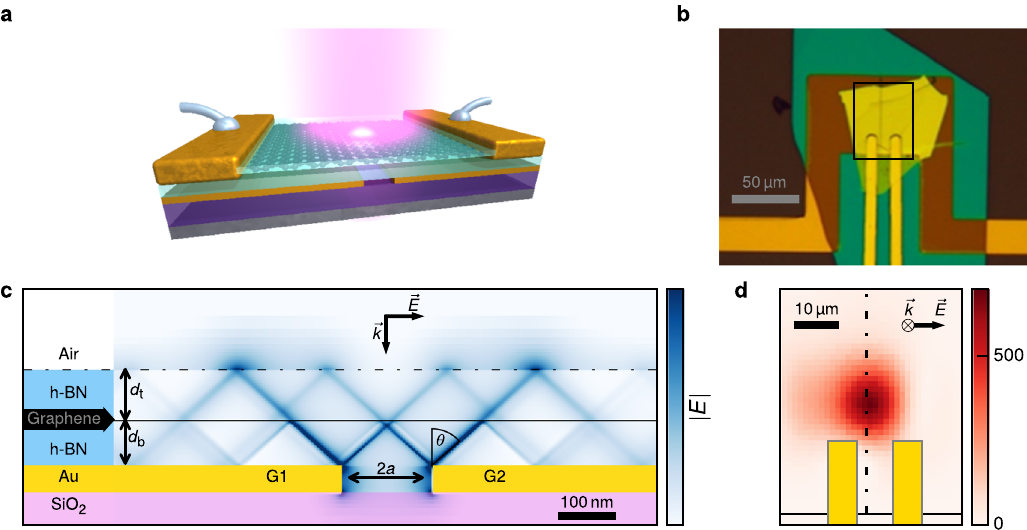
Fig. 1 Device schematic and working principle. a Schematic of the encapsulated graphene pn-junction. The h-BN/graphene/h-BN is placed on two gold split gates and contacted electrically by the edges. b Optical image of one device: the top ( bottom ) BN is blue ( yellow ). The black rectangle indicates the measurement region in d . The distance between the two gates in this device is 100 nm. c Side view of the propagating hyperbolic phonon-polaritons simulated by FDTD for the device in b . The thickness of the bottom h-BN is 50 nm and the top h-BN is 55 nm. HPPs are launched at the edges of the split gates and propagate as directional rays. While they cross the graphene plane they are partially absorbed leading to a temperature increase in the graphene. d Spatial map of the device responsivity for a polarization of the laser perpendicular to the gap of the split gate. The photoresponse arises at the junction, indicated by the dashed dotted line. The graphene edge is indicated by the solid black line. The gate voltages used here are ( V g1 = 1.2 V and V g2 = − 0.21 V). The electric fi eld polarization and propagation direction ( E , k ) are represented in c and